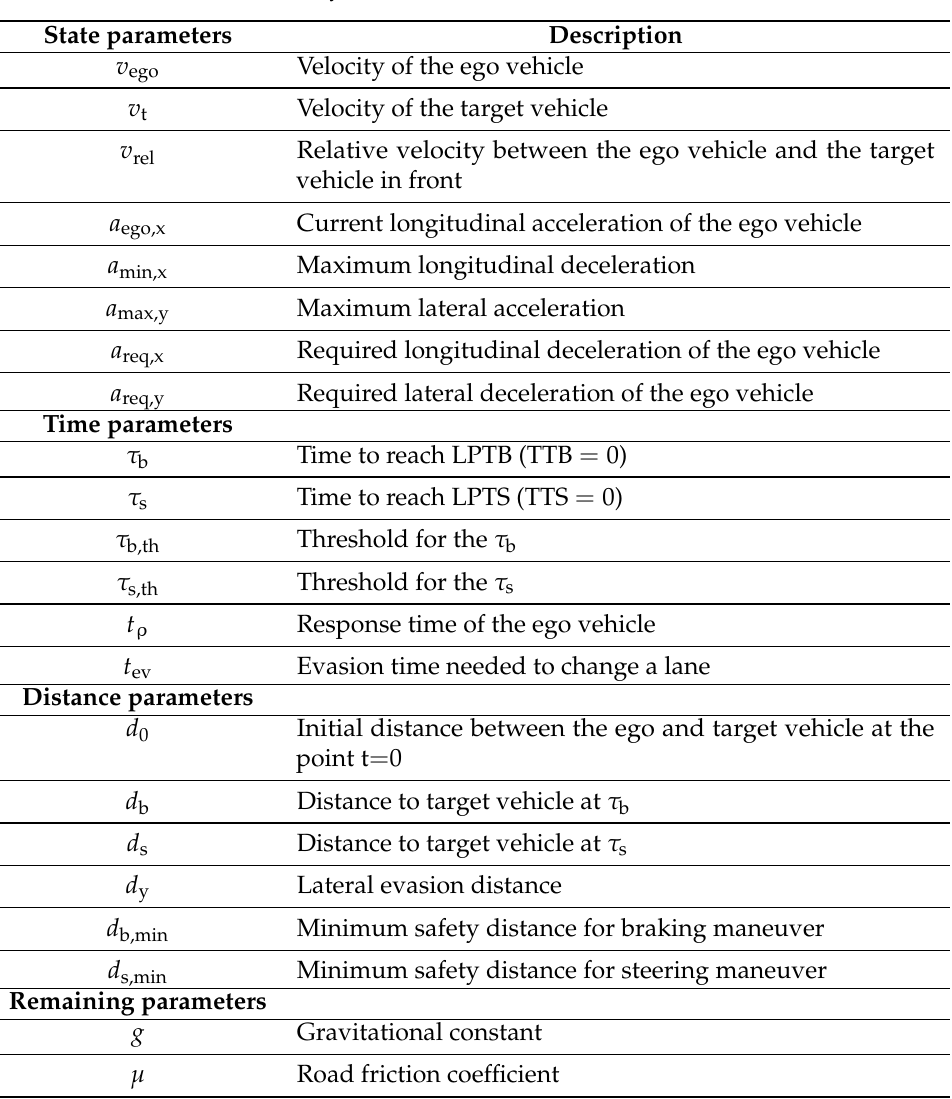
Figure 1. Visualization of steering and braking possibilities. Table 1. Parameters used for safety metrics and